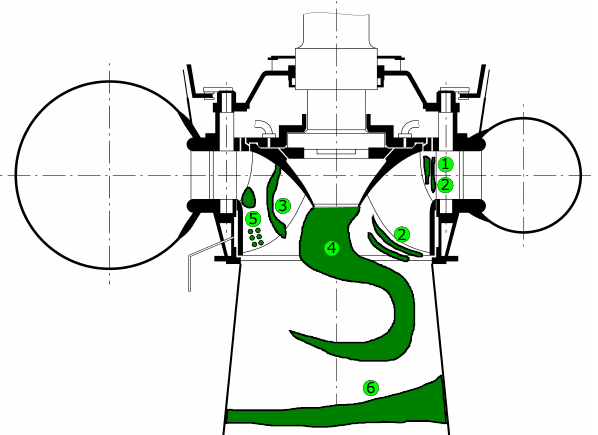
Figure 7. Possible phenomena at a Francis turbine. ( (cid:192) RSI, (cid:193) VOS, (cid:194) ICV, (cid:195) DTV, (cid:196) SPP, (cid:197) FSO ), Figure adapted from [34].